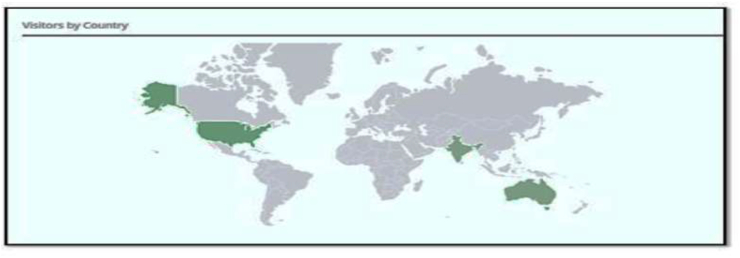
This figure depicts the Endocrine website visitors according to their country and the green shaded area represents the countries where people have browsed this website. (For interpretation of the references to colour in this figure legend, the reader is referred to the Web version of this article.)